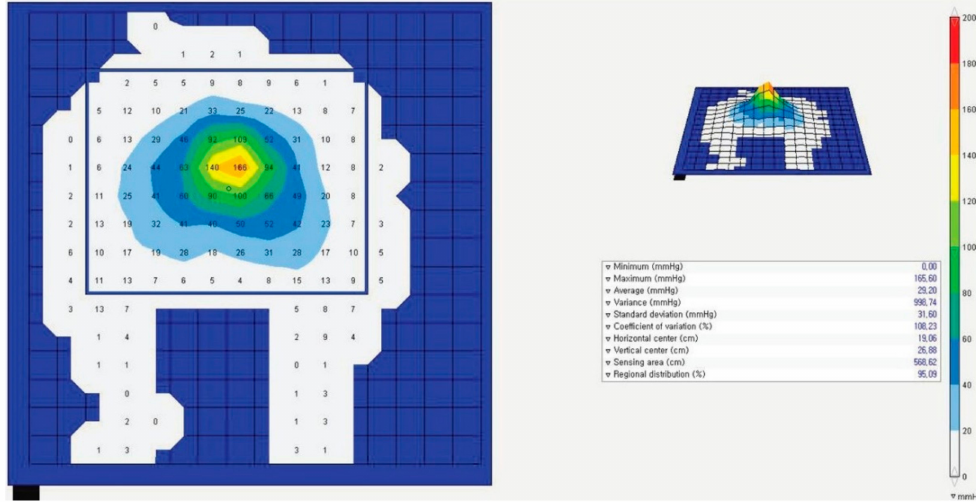
Figure 1. Sample of the pressure-distribution-analyzing